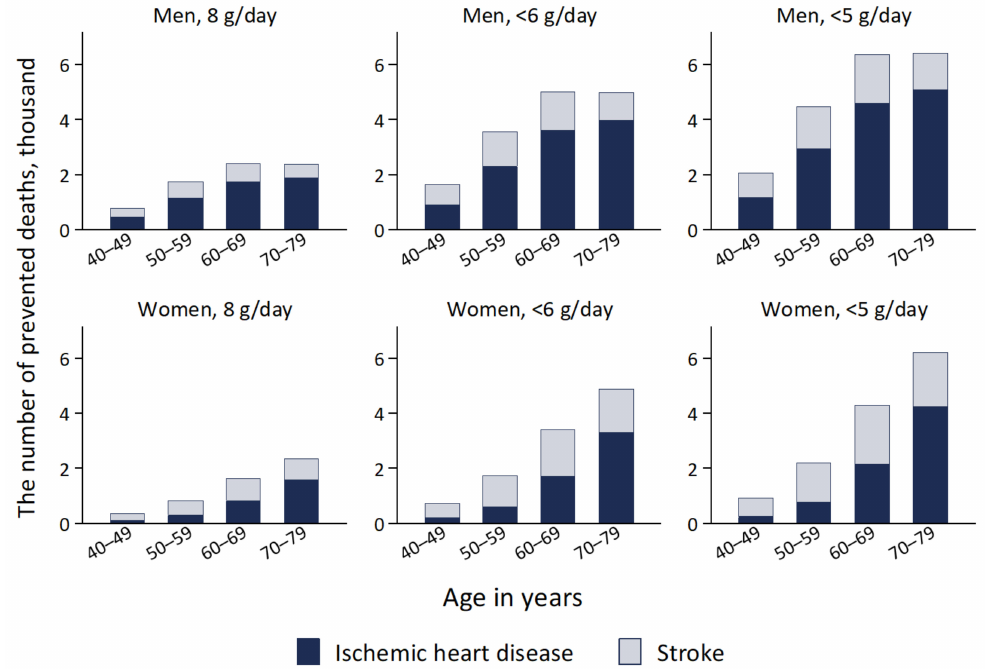
Figure 3. Projected cumulative prevented deaths from ischemic heart disease and stroke by reducing mean dietary salt intake to 8 g/day, <6 g/day, and <5 g/day between the years 2019 and 2029 in a closed cohort of population aged 40–79 years in